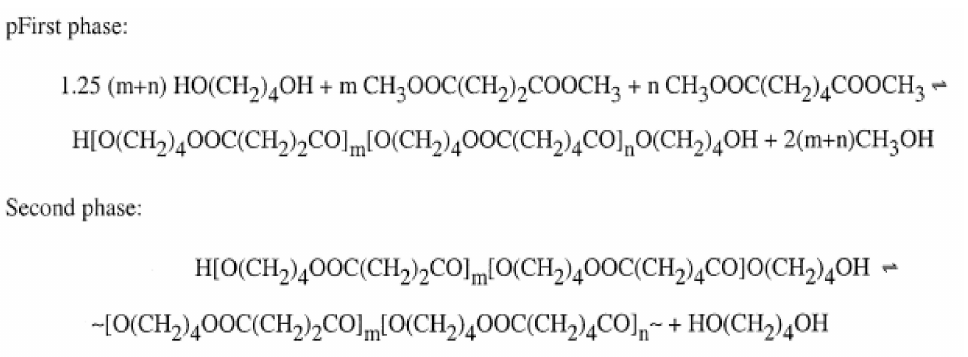
Figure 9. Synthesis of the aliphatic copolyesters [49]. Adapted with permission from Jiang and Loos